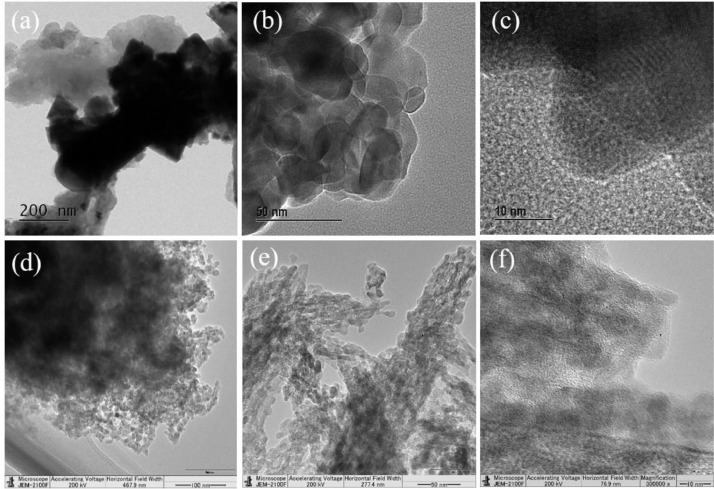
FE-TEM micrographs of (a) C3N4 and (b&c) and (d-f) Fe2O3 /nitrogen-rich carbon layers prepared at 350 °C and 450 °C, respectively.